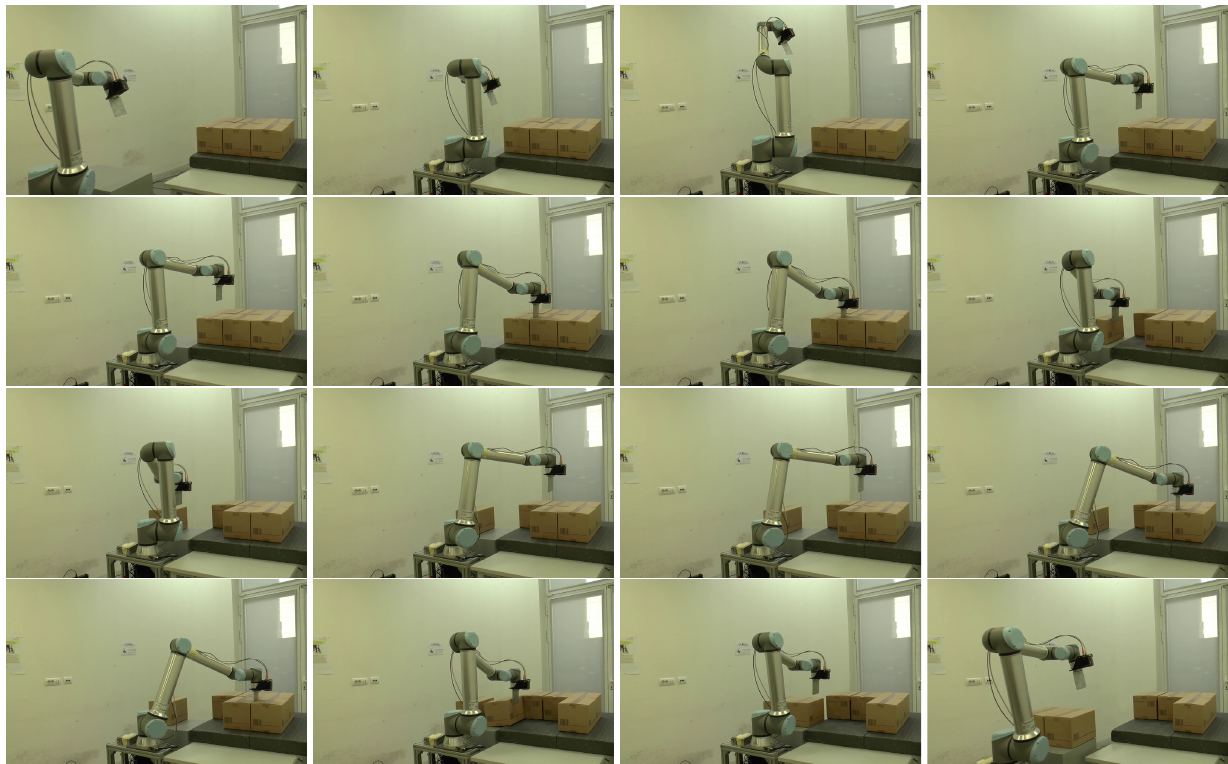
Figure 7. From top-left to bottom-right: a sequence showing the execution of a 2-boxes depalletizing task by the mobile manipulator.